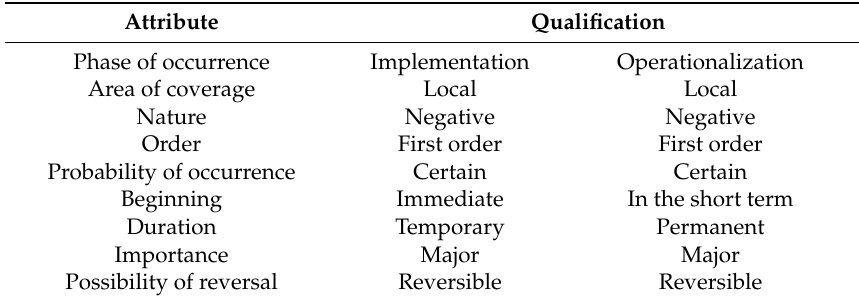
Table 11. Environmental Impact Matrix of the Implementation and Operationalization phases.